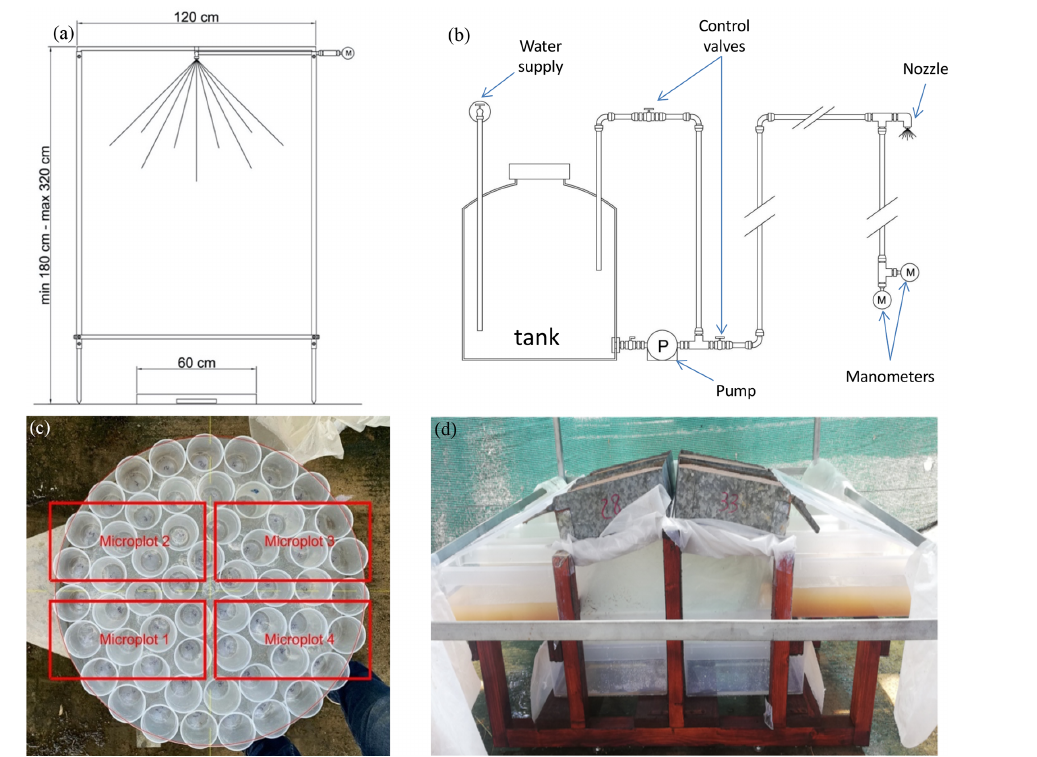
Figure 2. (a) Scheme of the rainfall simulator and (b) the hydraulic setup. (c) Arrangement of the plastic cups to evaluate rainfall intensity uniformity and overlap between the plastic cups and the soil trays (in red). (d) View of the experimental soil trays during a rainfall simulation